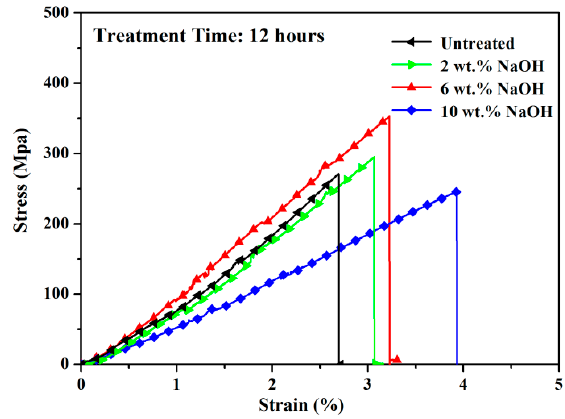
Figure 9. Typical Stress-Strain Curves for untreated and 2–10 wt.% NaOH treated bamboo fibers. Table 1. Mechanical properties of bamboo fibers before and after alkali-treatment. NAOH Concentration